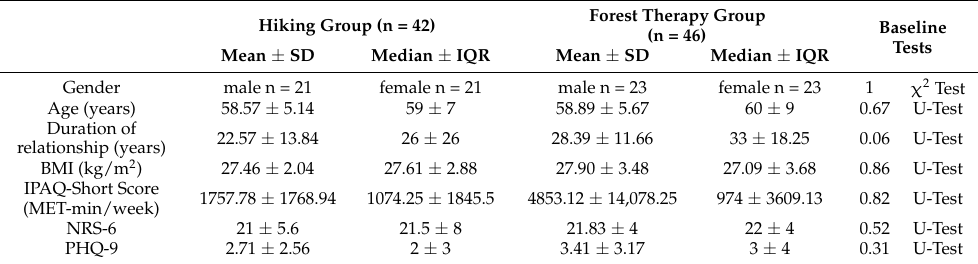
Figure 2. Study flowchart of included and excluded patients. Table 1. Baseline characteristics of the study population regarding inclusion